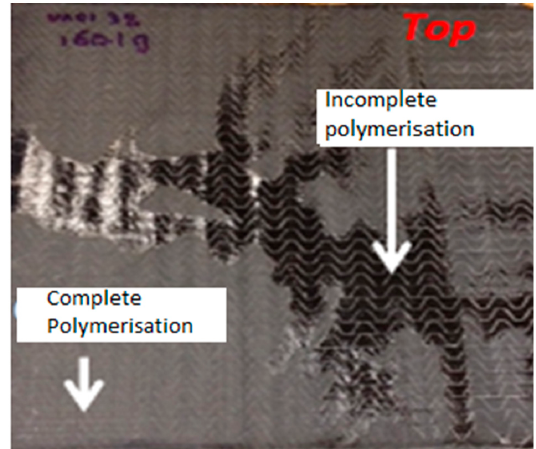
Figure 3. Incomplete polymerisation due to deactivation of initiator.